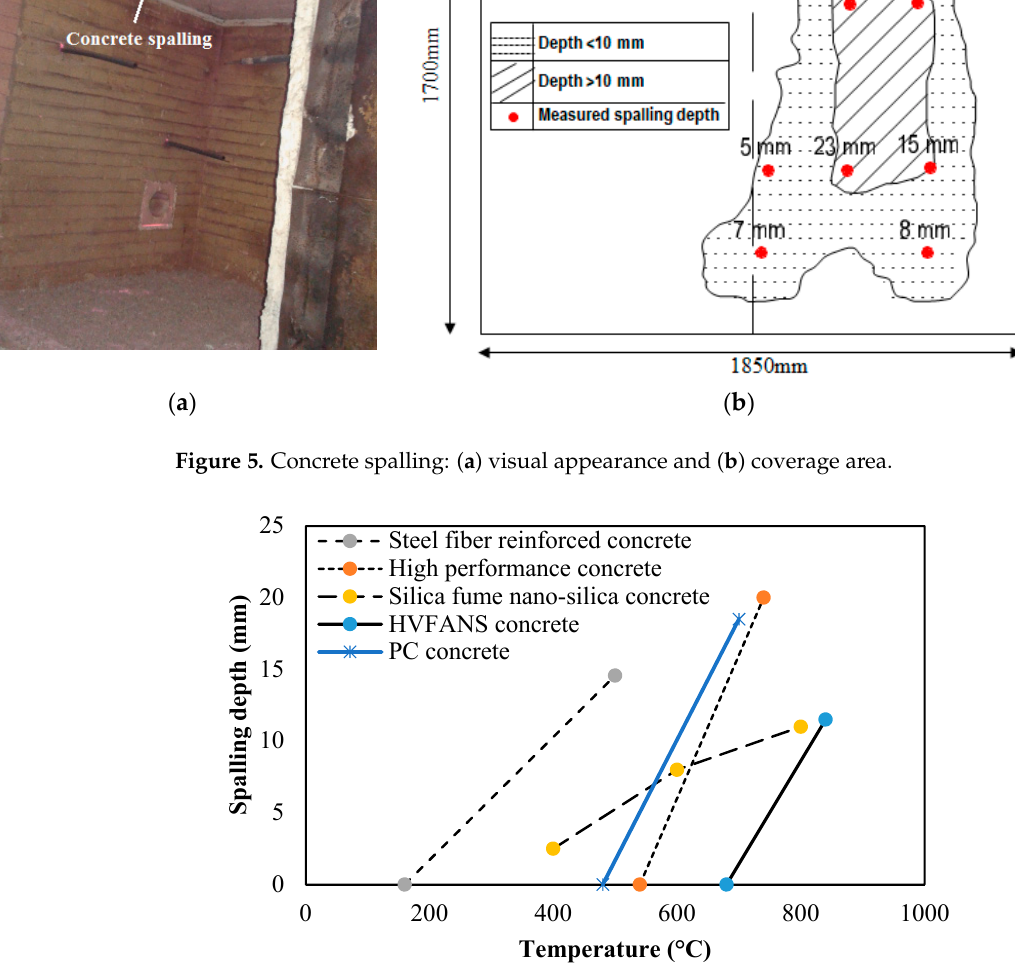
Figure 6. Concrete spalling depth at different temperatures [53,54,56].